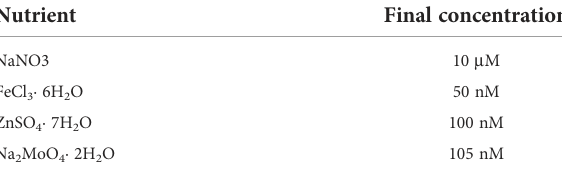
TABLE 1 Mesozoic/Cenozoic concentration of nutrients. Ratti et al., 2011. Nutrient